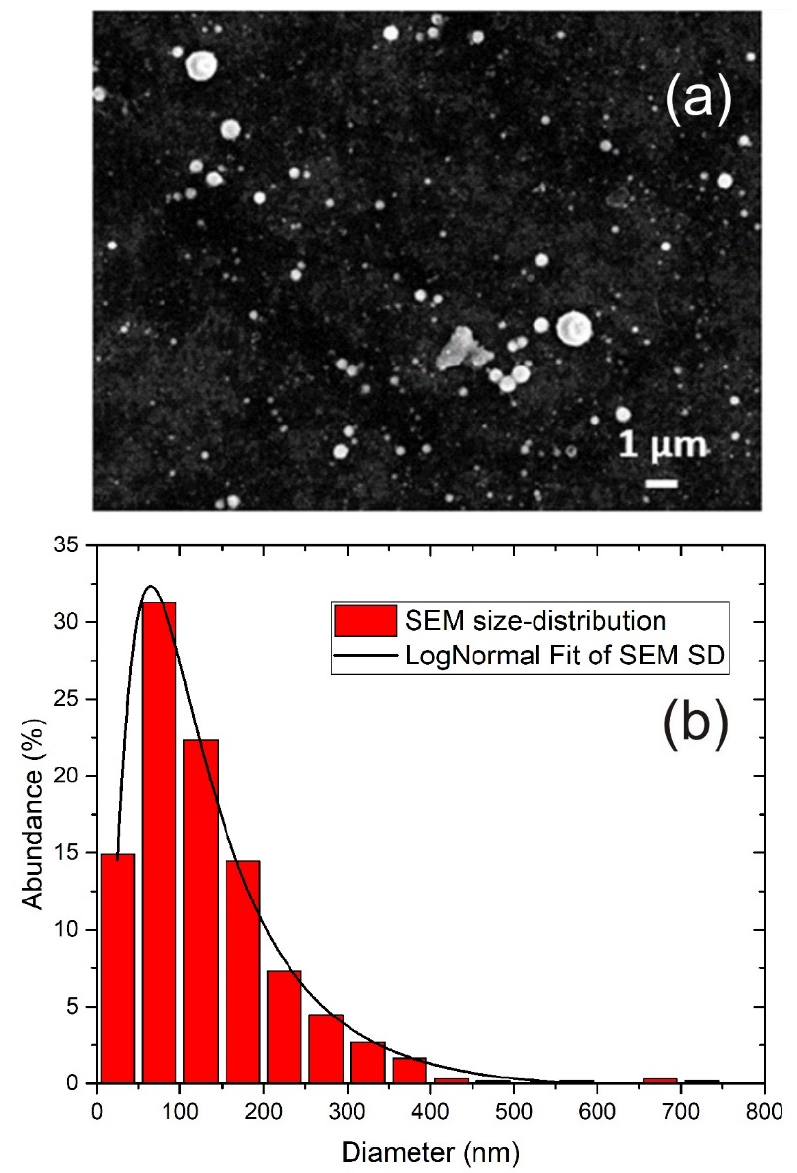
Figure 2. ( a ) SEM image of TiO 2 nanoparticles (5000 pulses applied in ablation) and ( b ) size distribution of TiO 2 NP from SEM including Log-Normal Fit.